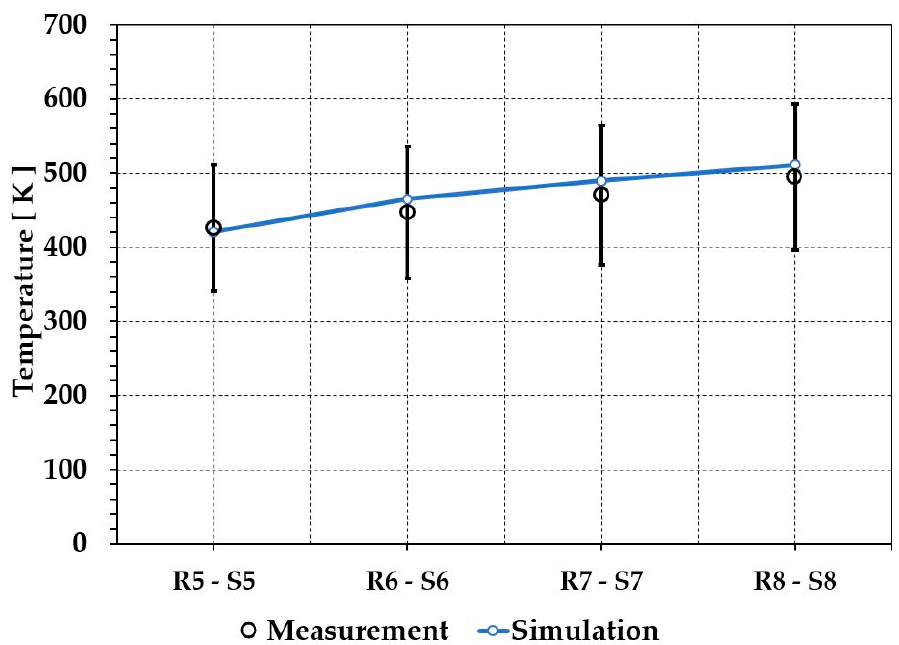
Figure 7. Temperature comparison between measurement and simulation.